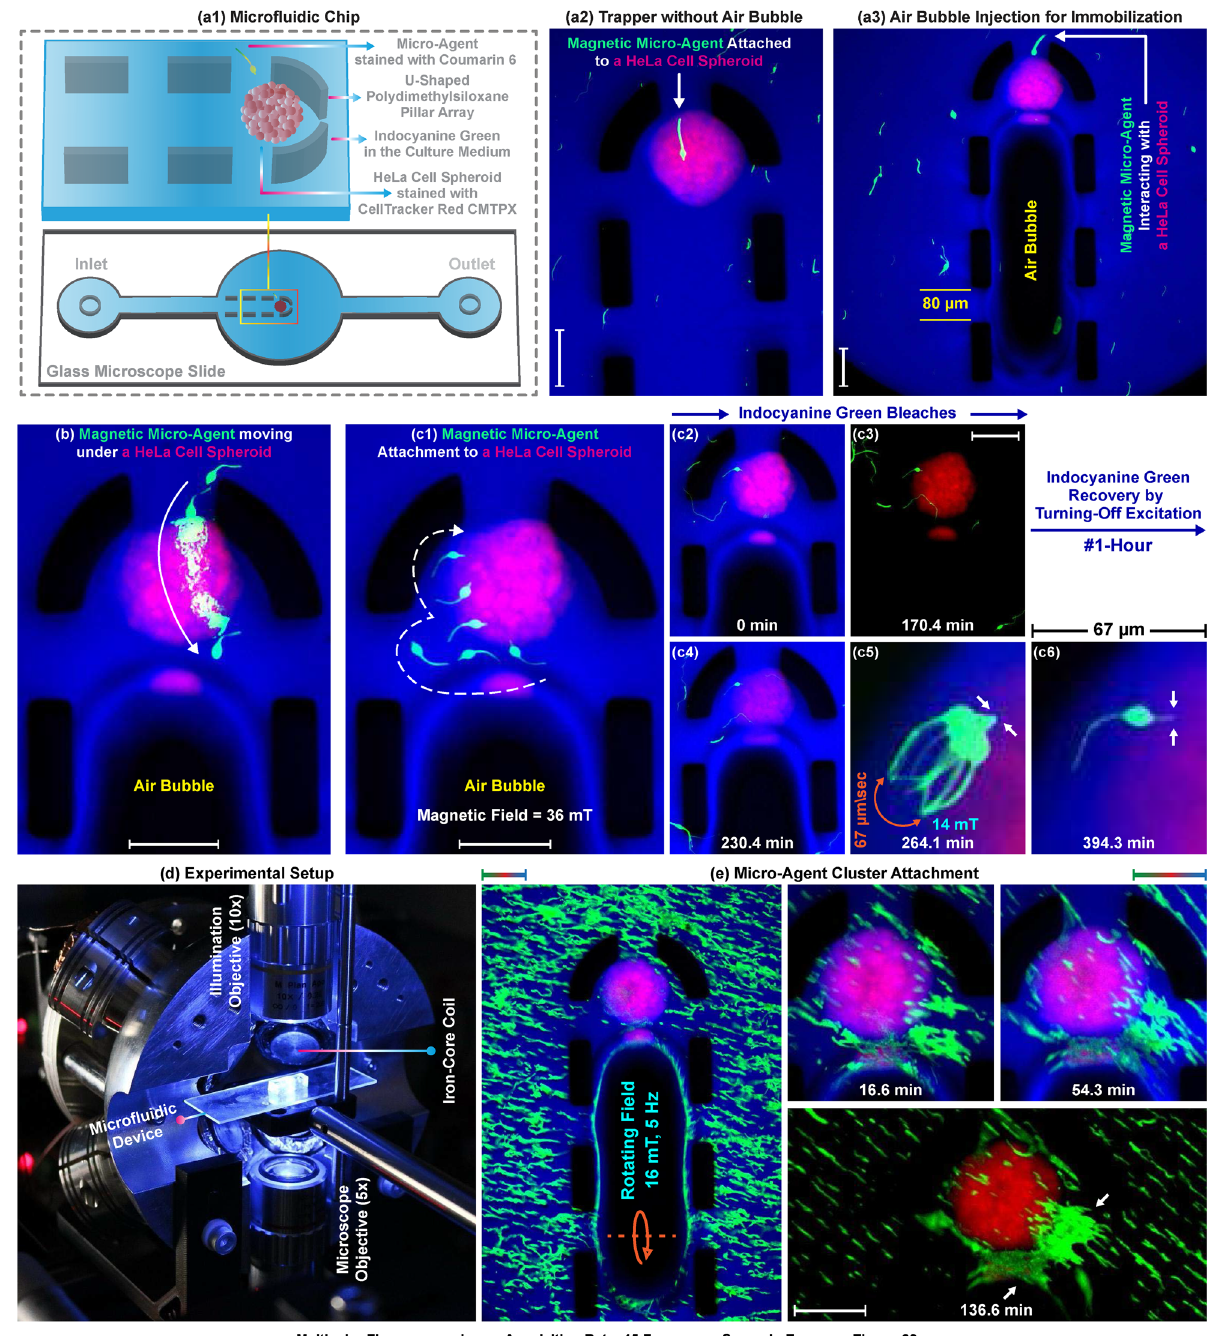
Figure 6. Multicolor fluorescence microscopy for visualizing the magnetic micro-agents in a microfluidic environment. ( a1 ) Layout of the chip designed for immobilizing a single HeLa cell spheroid. ( a2 ) Micro-agent attached to a trapped spheroid. ( a3 ) Immobilizing a spheroid using an air bubble. ( b ) Overlaid image shows a micro-agent traveling under an immobilized spheroid. ( c1 ) Attachment of a micro-agent to an immobilized spheroid. ( c2 – c4 ) Fluorescence recovery after photobleaching of indocyanine green. ( c5 ) Attachment check by magnetically moving the micro-agent. ( c6 ) Arrows indicate the part of the micro-agent inside the spheroid. ( d ) Workspace of the setup used for microscopy and magnetic actuation. ( e ) Formation of a micro-agent cluster attached to the spheroid. Scale bar 100 µ m. Please refer to the accompanying video (Part